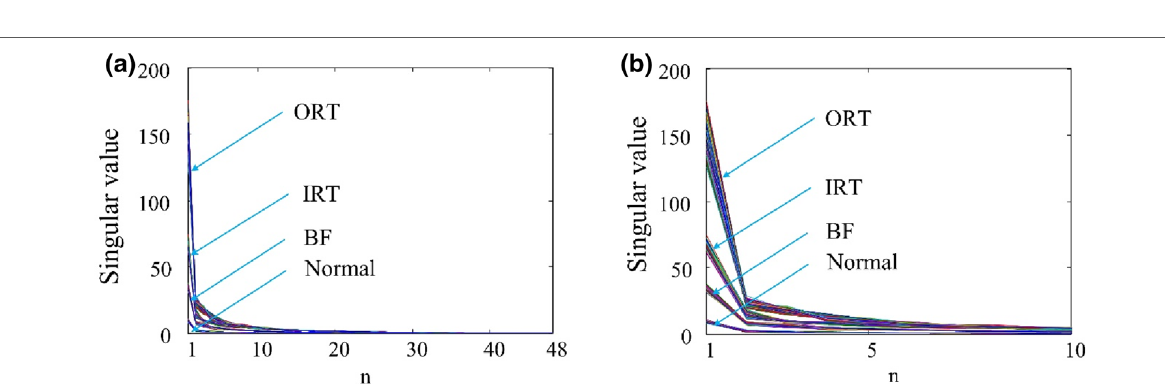
Figure 13 Feature extraction result by GST and SVD methods: ( a ) first 48 order; ( b ) first 10